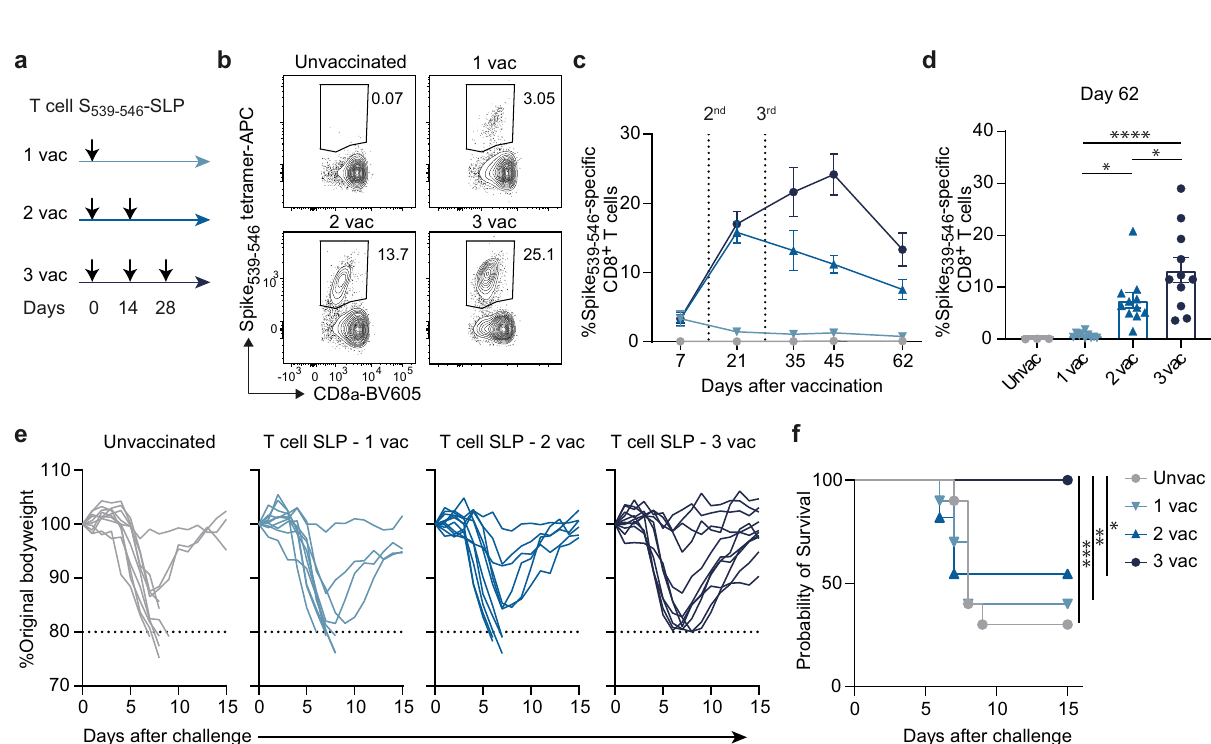
Fig. 1 Vaccines eliciting antibodies against con fi rmational proteins but not linear B cell epitopes are neutralizing and effective against SARS-CoV-2 infection. a C57BL/6 mice were vaccinated subcutaneously (s.c.) on day 0, 14, and 28 with synthetic long peptides (SLPs) consisting of PADRE-coupled linear B cell epitopes adjuvanted or not with CpG and/or Inactivated Freund ’ s Adjuvant (IFA) (Mock, IFA: n = 5; CpG, CpG + IFA: n = 3). Spike-speci fi c IgG kinetics in blood are shown. b Representative fl ow cytometry plots of PADRE-speci fi c CD4 + T cells in naïve unvaccinated mice and in day 21 post- vaccinated mice. c PADRE-speci fi c CD4 + T cell response on day 21 after vaccination as described in ( a ) (Naïve: n = 11; Mock, IFA: n = 5; CpG: n = 3; CpG + IFA: n = 13). * P = 0.048, *** P = 0.0007, **** P = <0.0001. d C57BL/6 mice were vaccinated as described in ( a ) with SLPs consisting of the B cell epitope (E) alone, the epitope combined (uncoupled) with the PADRE (P) peptide (E + P) or N-terminal and C-terminal PADRE coupled to the B cell epitope (P − E, E − P), and all adjuvanted with CpG and IFA (E, E + P, E − P: n = 5; P − E: n = 3). Endpoint dilutions of Spike-speci fi c IgG in blood at day 42 after vaccination with Spike 405-422 -SLP are shown. * P = 0.035, ** P = 0.005, *** P = 0.0004. e – h K18-hACE2 transgenic mice were vaccinated on day 0, 14, and 28 with one or fi ve SLP vaccines containing a PADRE-coupled linear B cell epitope adjuvanted with CpG and IFA. Four weeks after the fi nal vaccination, mice were intranasally infected with SARS-CoV-2 ( e – g , Unvaccinated: n = 9; B cell SLP 1 epitope, B cell SLP 5 epitopes: n = 10). e Spike-speci fi c IgG kinetics in blood. f Weight loss kinetics after SARS-CoV-2 challenge. g Survival graph after SARS-CoV-2 challenge. h SARS-CoV-2 neutralizing capacity by antibodies after B cell-SLP vaccination on day 42 measured by a WT virus neutralization assay (VNA) (Unvaccinated, B cell SLP 1 epitope, n = 2; B cell SLP 5 epitopes, n = 5). i – n K18-hACE2 mice were vaccinated intradermally on day 0, 21, and 42 with a Spike-encoding DNA vaccine. i Spike-speci fi c IgG (Unvaccinated: n = 3; Spike DNA: n = 6), j weight loss kinetics and k survival graph after SARS-CoV-2 challenge ( n = 10 per group). **** P = < 0.0001. l SARS-CoV-2 neutralizing capacity by antibodies after Spike DNA vaccination on day 55 measured by a VNA. Data represented as mean ± SEM (Unvaccinated: n = 1; Spike DNA: n = 6). m Kinetics of Spike 539-546 -speci fi c CD8 + T cells in blood. Data represented as mean ± SEM (Unvaccinated: n = 3; Spike DNA: n = 6). n Kinetics of KLRG1 + CD62L − expression on Spike 539 − 546 -speci fi c CD8 + T cells in blood. Data represented as mean ± SEM ( n = 6).